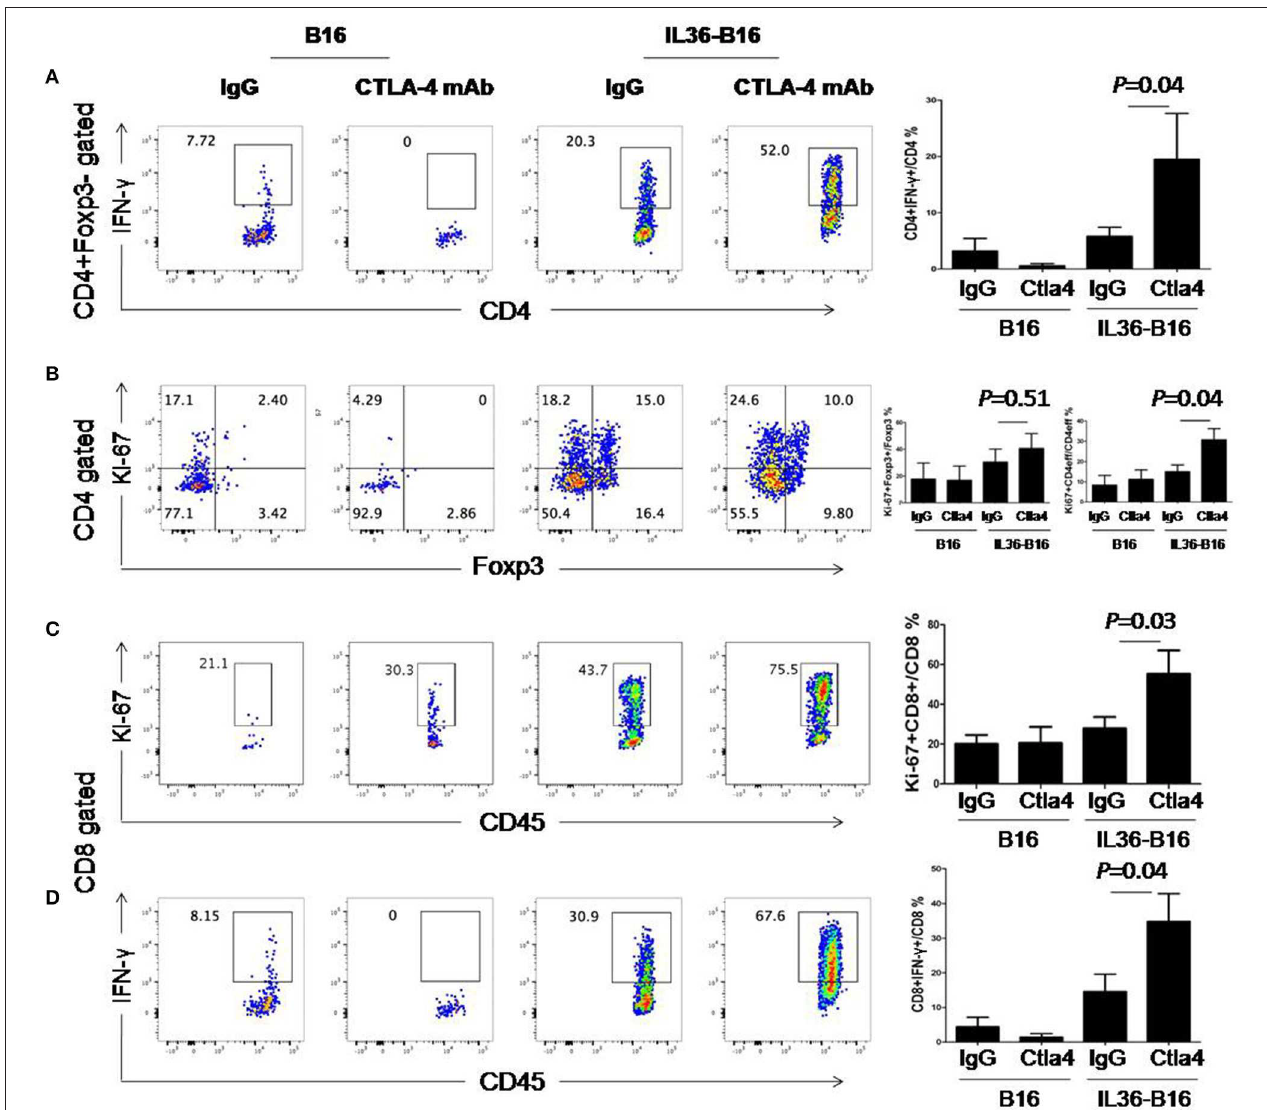
FIGURE 6 | Combination of tumoral expression of IL-36 and anti-CTLA-4 mAbs additively enhanced type 1 immune responses in the tumor microenvironment. C57BL/6 mice were injected i.d. with 10 4 B16 or B16-IL-36 cells and were subsequently treated with CTLA-4 or control mAbs ( n = 3 mice/group). Tumors were resected after treatment and subjected to flow cytometry analysis. Representative flow cytometric plots showed IFN- γ + Foxp3 − CD4 + T cells (A) , Ki-67 + Foxp3 − CD4 + T cells (B) , Ki-67 + CD8 + T cells (C) , IFN- γ + CD8 + T cells (D) . Results are mean ± SEM of three independent